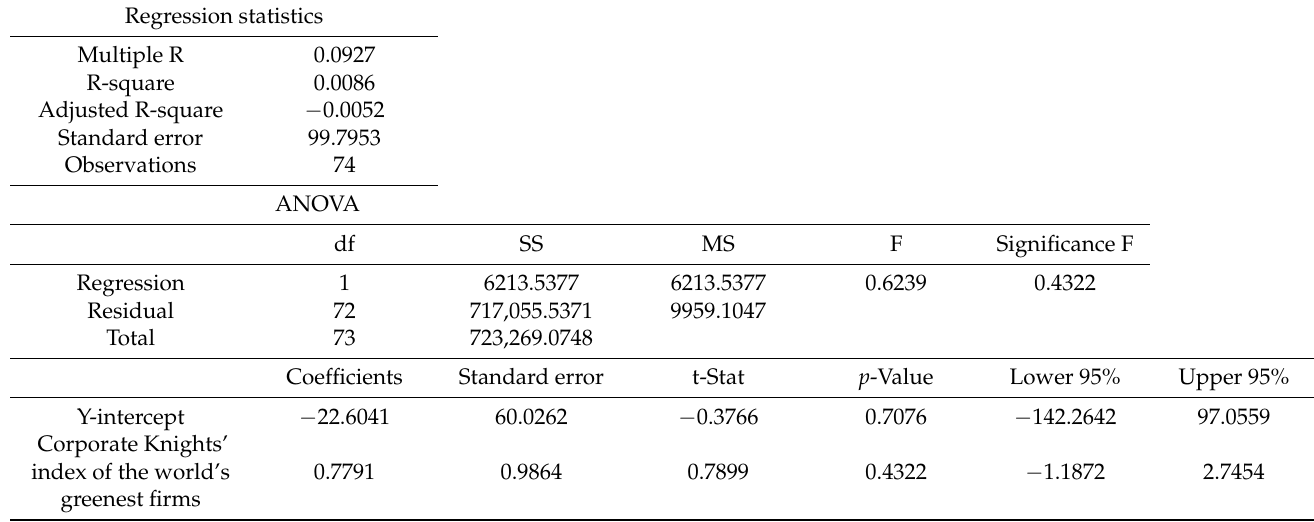
Table 5. Regression analysis of the dependence of the risk of the reduction of the value of assets on the level of corporate social responsibility in 2020–2021.